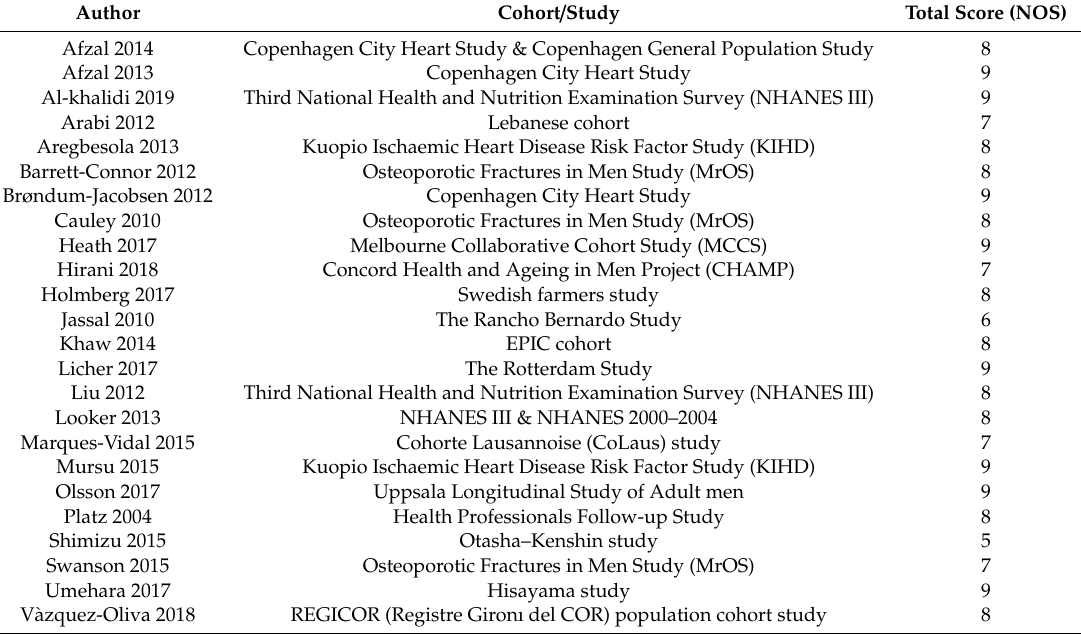
Table 2. Total Newcastle Ottawa Score (NOS) for studies included in the SR. NOS ranges from 0 (low quality) to 9 (best quality). NOS scale aims to assess the quality of studies in three domains related to the selection process: comparability of cohorts and outcome assessment and adequacy. Total score resulted by two-blinded reviewers’